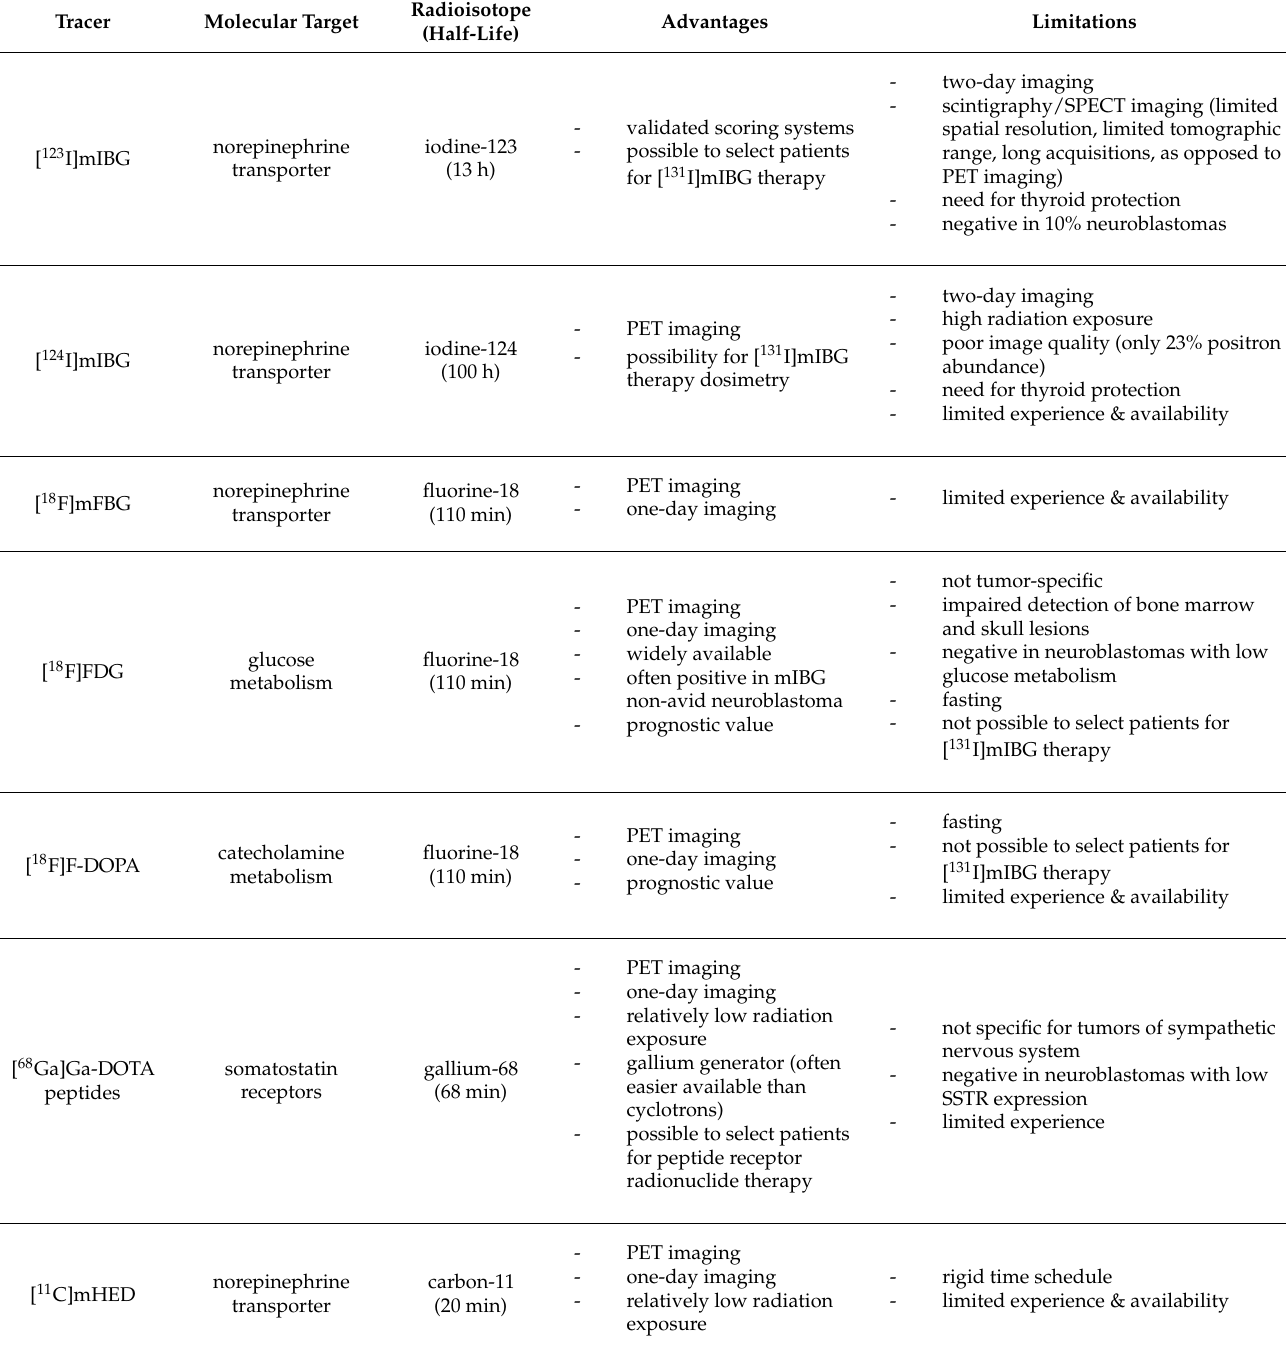
Table A1. characteristics of radiotracers for nuclear imaging of